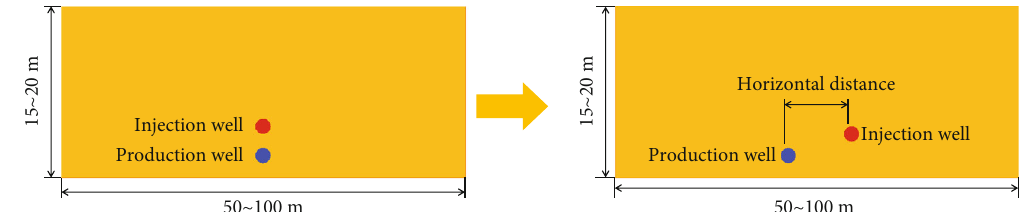
Figure 3: Schematic map for the change of horizontal well pairs